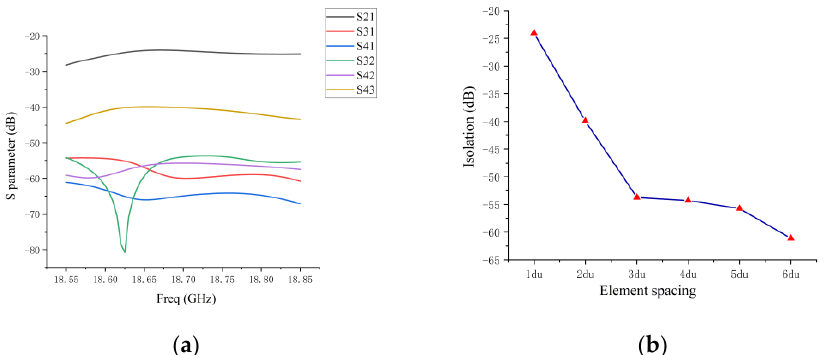
Figure 7. ( a ) Simulated coupling between antenna elements in sparse array; ( b ) the maximum values of simulated coupling between antenna elements with different du of sparse array in operating frequency band.